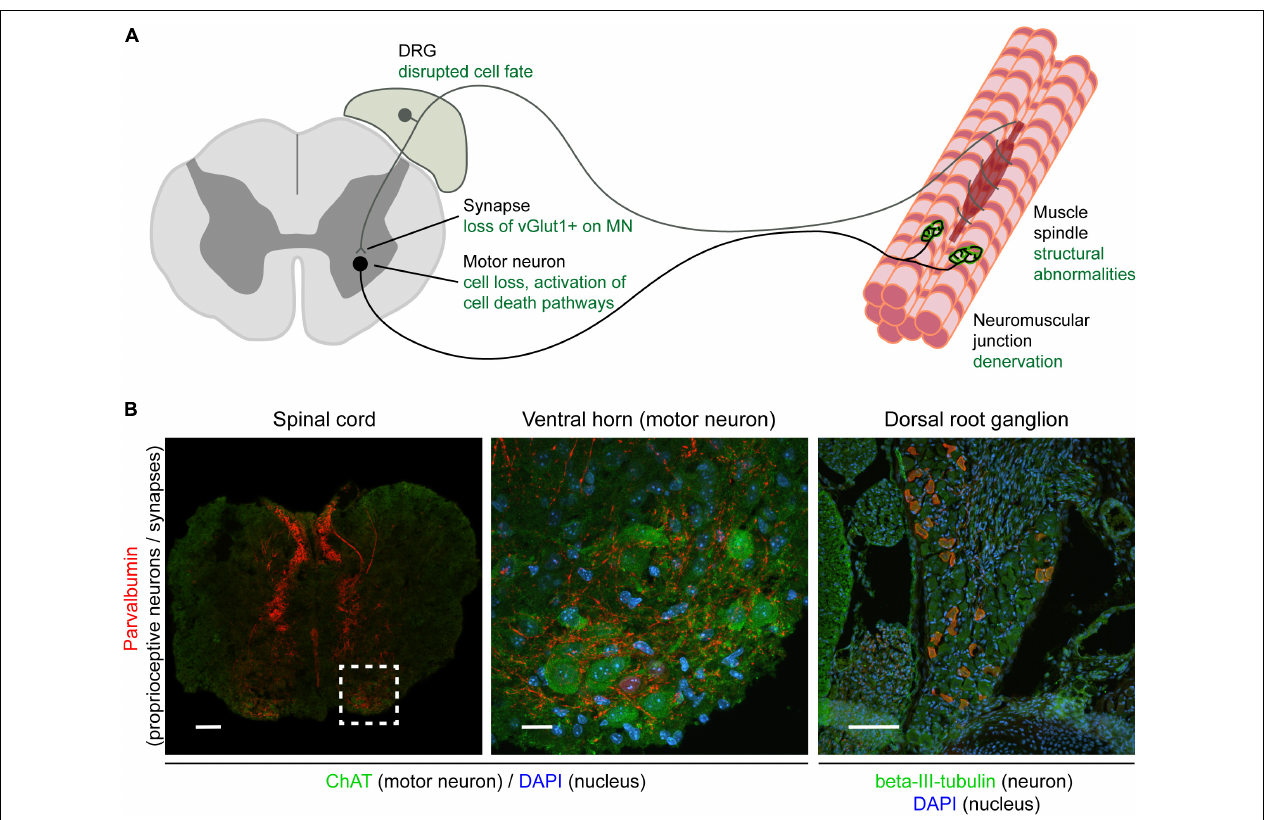
FIGURE 1 | Overview of the sensory-motor system and pathologies observed in SMA. Schematic (A) and immunohistochemical (B) representation of the sensory-motor system, focusing on structures, cell types, and subcellular compartments that have been implicated in SMA pathogenesis. In (A) , the text in green indicates the primary pathological changes occurring in specific cell types or in specific subcellular compartments. In (B) , immunofluorescence was used to label parvalbumin-expressing cells and projections (proprioceptive neurons; red), neuronal cell bodies (ChAT for motor neurons, beta-III-tubulin for DRG cell bodies; green), and nuclei (DAPI; blue). Note that only a subgroup of DRG cell bodies express parvalbumin and that other markers such as NF200 + (mechano- and proprioceptive) and peripherin + (nociceptive) can also be used to identify other types of sensory neurons. Scale bars: 100 µ m (spinal cord and DRG); 20 µ m (motor neuron). DRG, dorsal root ganglion; ChAT, acetylcholine transferase; DAPI, 4,6-diamidino-2-phenylindole; vGlut1, vesicular glutamate transporter 1; NF200, neurofilament heavy polypeptide (200